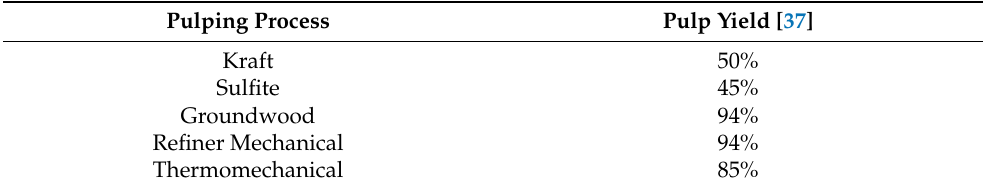
Table 7. Pulp yield of the different types of pulp considered. Pulping Process Pulp Yield